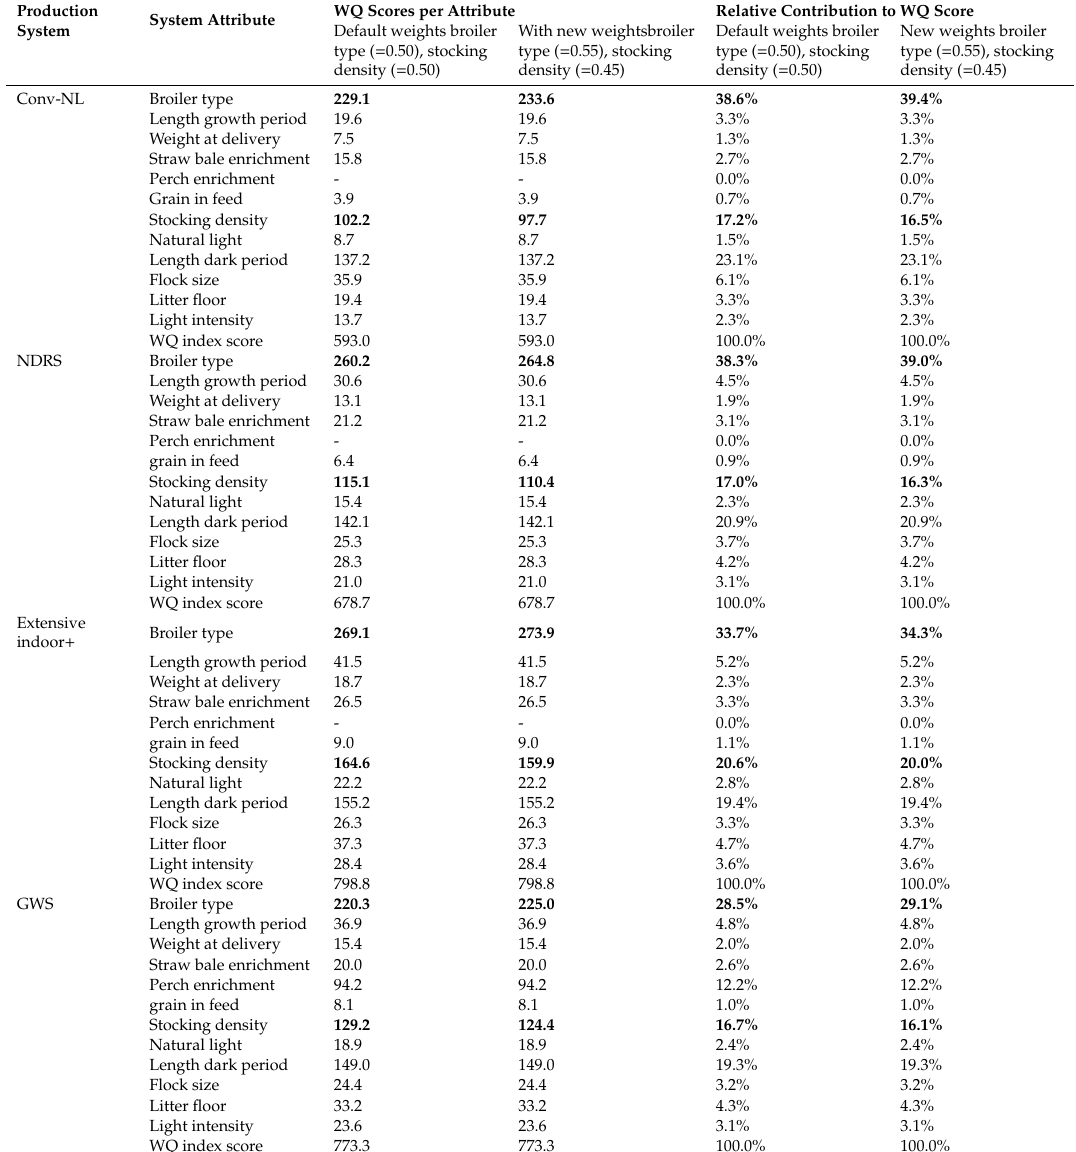
Table A3. Sensitivity analysis results on changing weights for the system attributes of the welfare measure panting in the Netherlands (changes are depicted in